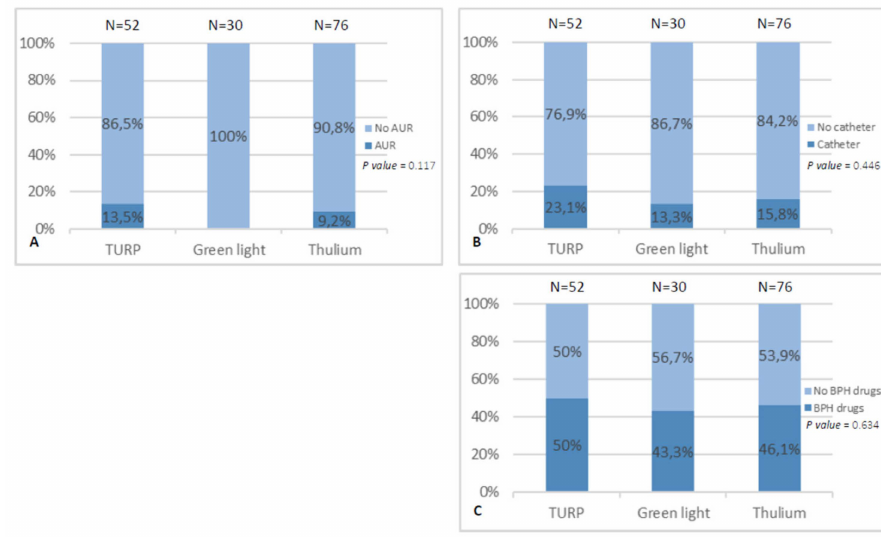
Figure 1. Surgical types versus three end points: ( A ) acute urinary retention (AUR) within 3 months after the operation; ( B ) catheterization status on discharge; ( C ) α -blocker usage 3 months after surgery.